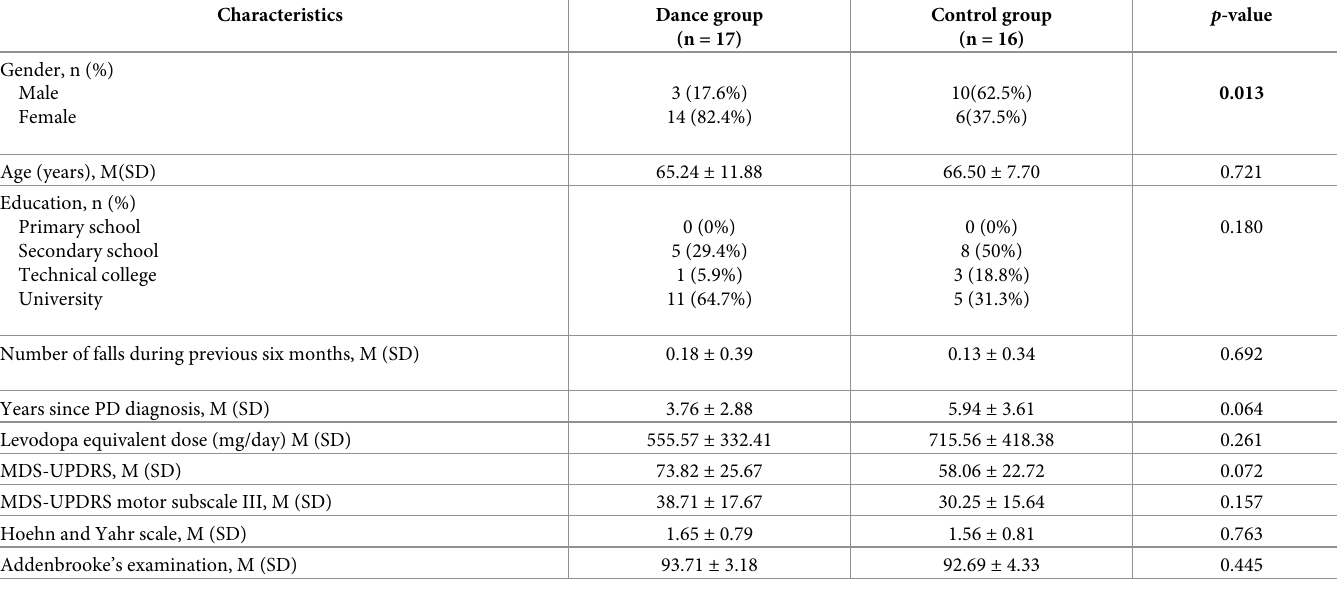
Table 1. Descriptive statistics and group comparisons of baseline and PD